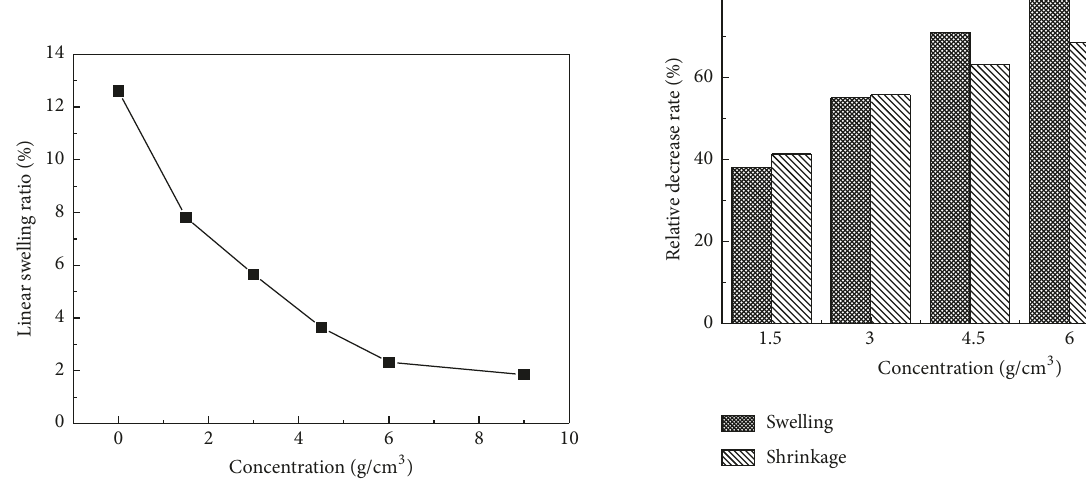
Figure 7: Relative decrease of LSWR and LSHR of different aggregate size specimens.